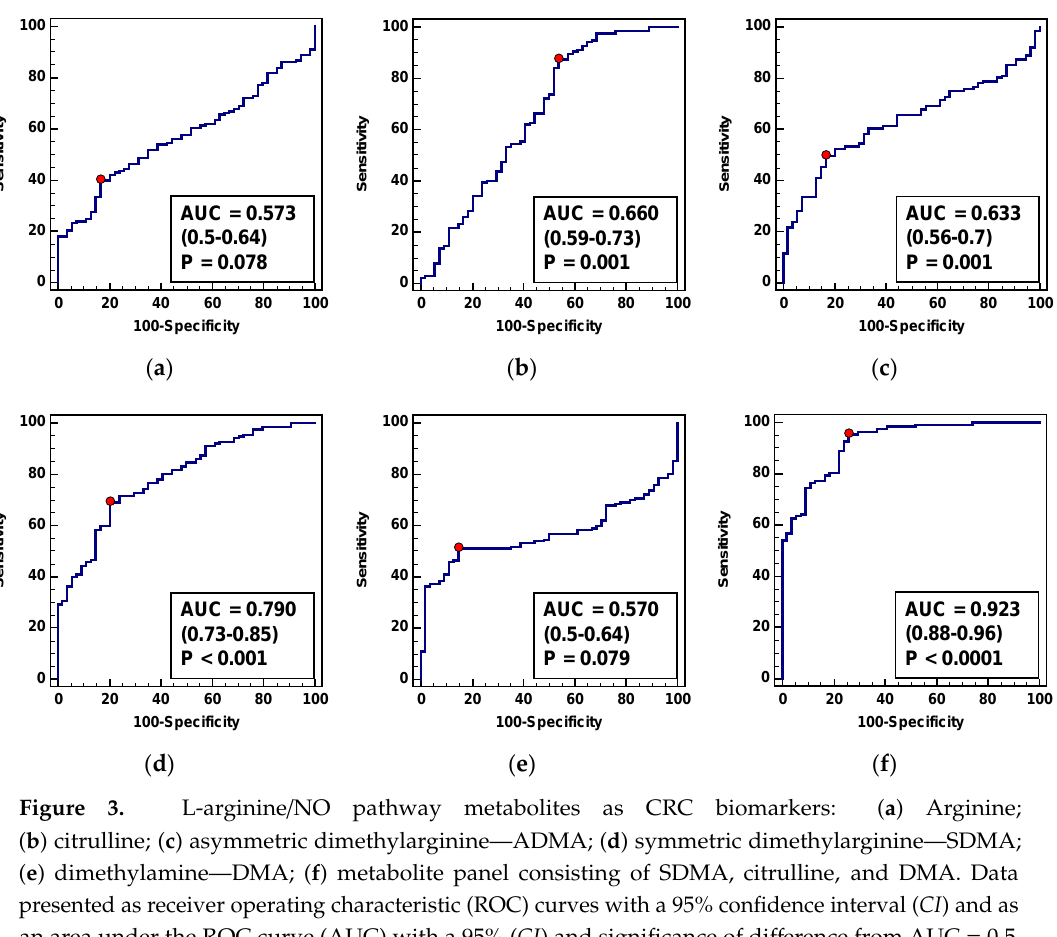
Figure 3. L-arginine / NO pathway metabolites as CRC biomarkers: ( a ) Arginine; ( b ) citrulline; ( c ) asymmetric dimethylarginine—ADMA; ( d ) symmetric dimethylarginine—SDMA; ( e ) dimethylamine—DMA; ( f ) metabolite panel consisting of SDMA, citrulline, and DMA. Data presented as receiver operating characteristic (ROC) curves with a 95% confidence interval ( CI ) and as an area under the ROC curve (AUC) with a 95% ( CI ) and significance of difference from AUC = 0.5, characteristic for a chance marker (represented as diagonal line). The red dot indicates Youden index. Table 6. Characteristics of L-arginine / NO pathway metabolites as CRC biomarkers in the general asymptomatic population. Marker Criterion Sens. and Spec.